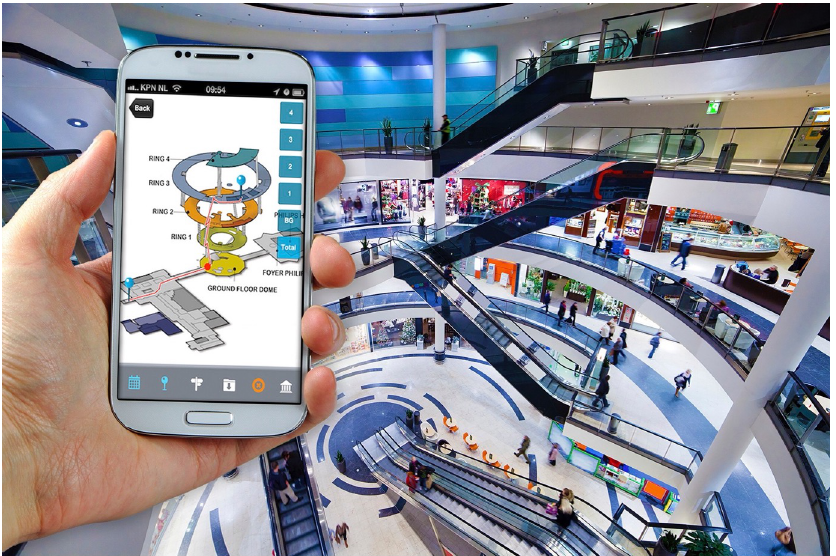
Figure 1. 3D indoor positioning application example in a multi-storey mall (by Unknown Author (https://meet.bnext.com.tw/blog/view/3442? accessed on 26 November 2022)— is licensed under CC BY-NC-ND)